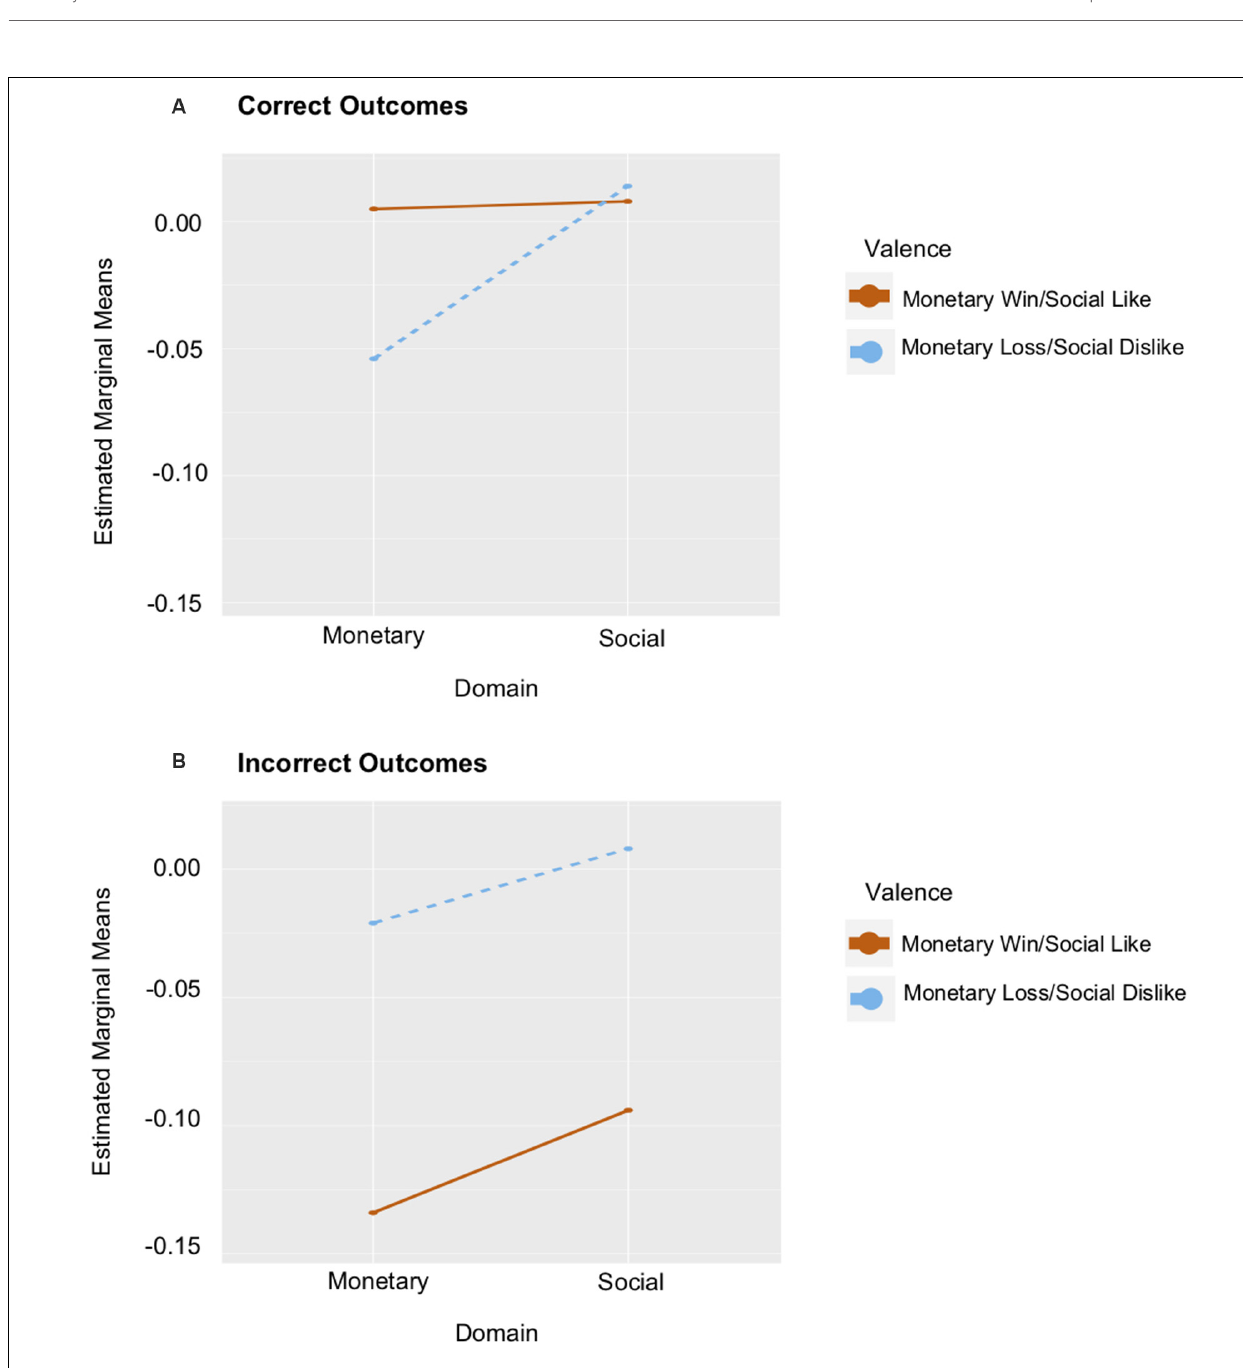
FIGURE 3 | Graphs of ventral striatum response to Domain × Valence controlling for Anxiety and Depression. (A) The red line depicts estimated marginal means of the monetary win and social like conditions for correct outcome trials. The dashed blue line depicts the estimated marginal means of the monetary loss and social dislike conditions for correct outcome trials. (B) The same relations are depicted for incorrect